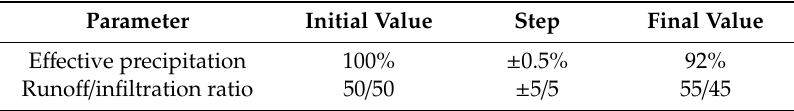
Table 1. Summary of parameters and steps used for